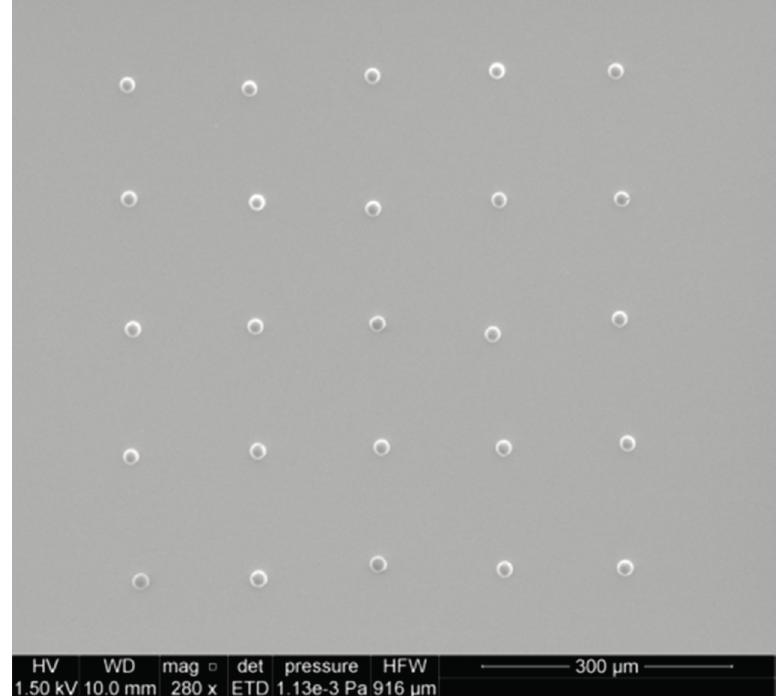
Figure 3. 5 × 5 particle array of ≈ 18 μ m diameter AN particles printed onto hydrophobic functionalized silicon substrate with a nominal spacing of 150 μ m between particles. Each particle was formed by evaporation of an ensemble drop of 5 inkjet microdrops containing ammonium nitrate deposited onto the same sample